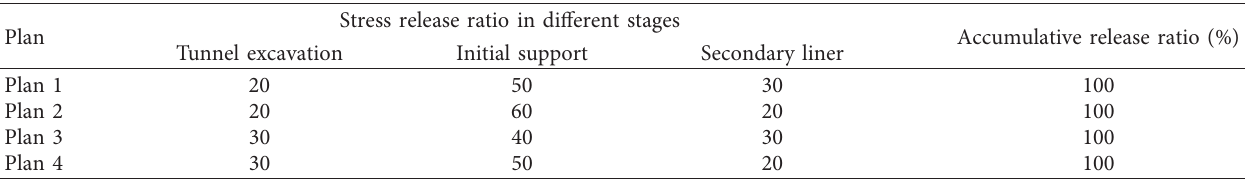
Table 3: Distribution of stress release ratio in different stages.